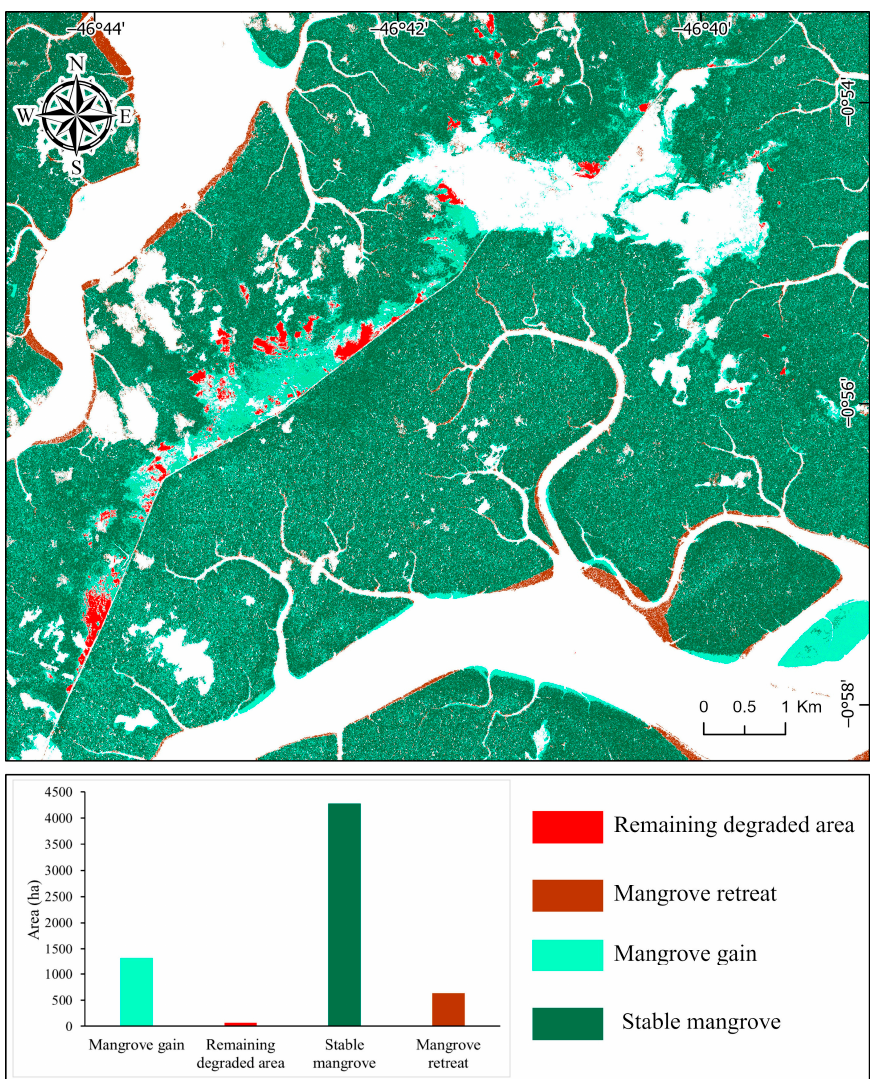
Figure 9. Spatial distribution of landcover changes based on the high-resolution dataset between 2003 and 2019.